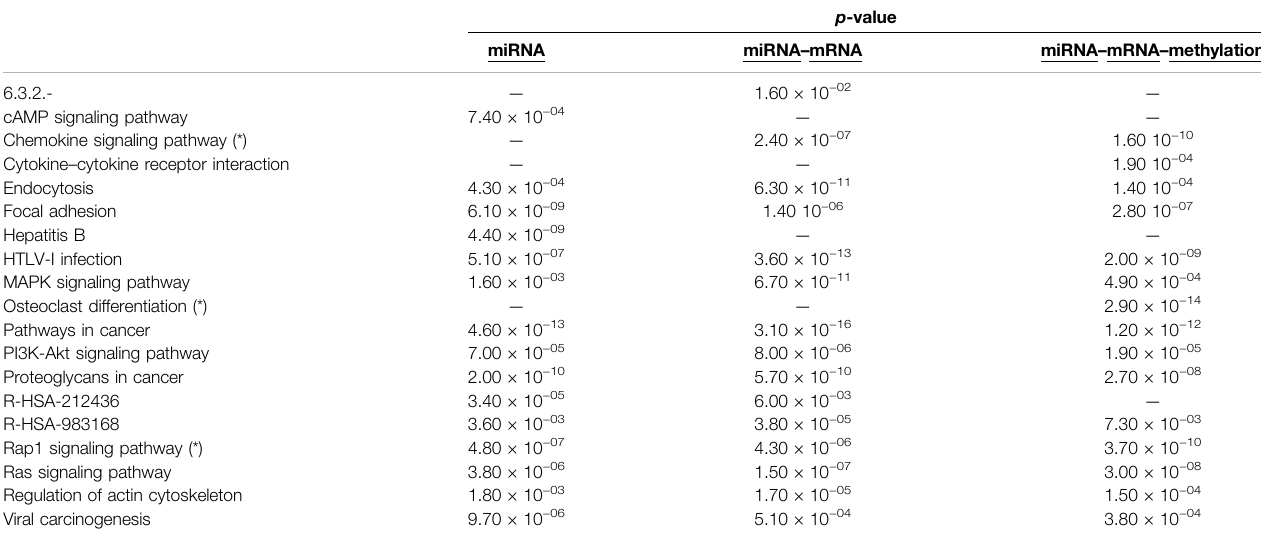
TABLE 2 | Comparison of the top 15 pathways of different biomarker sets.